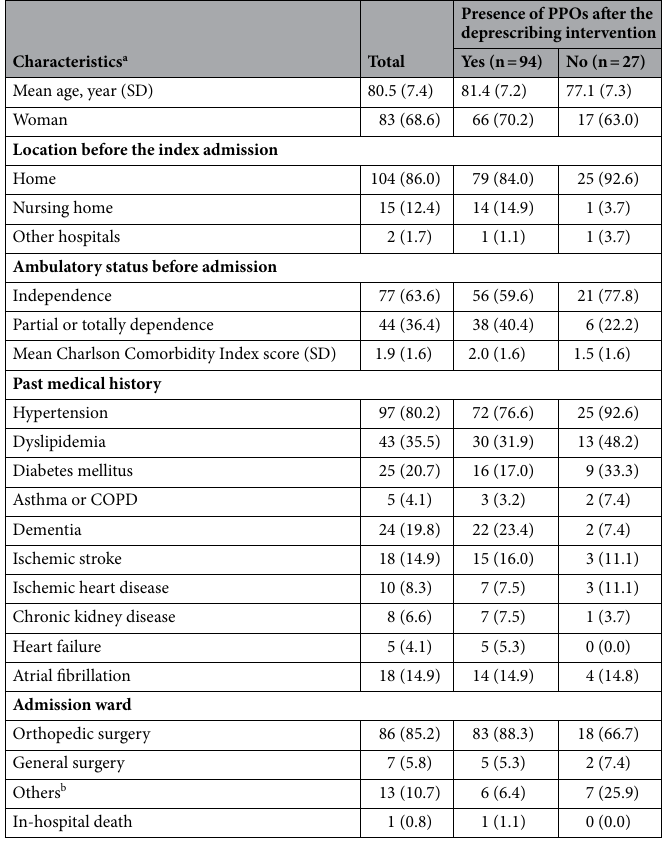
Table 1. Characteristics of 121 hospitalized elderly patients who received the in-hospital deprescribing intervention. COPD chronic obstructive pulmonary disease, PPO potential prescribing omission, SD standard deviation. a Values are expressed as the number with the percentage of the total number, unless otherwise stated. b Include neurosurgery (n = 5), oral surgery (n = 4), urology (n = 3), dermatology (n =